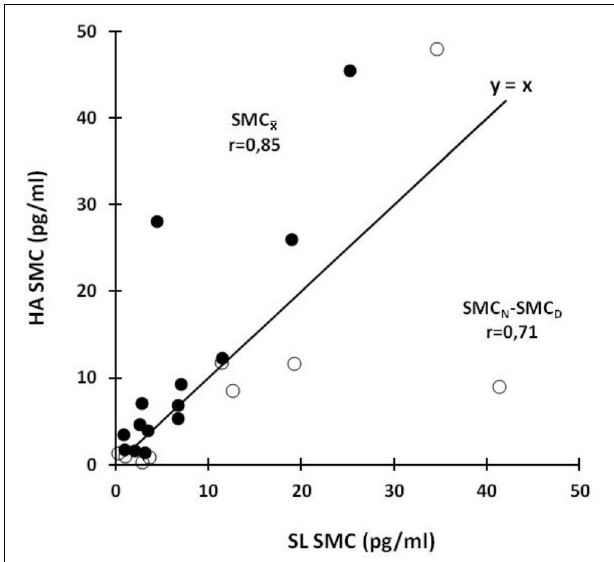
FIGURE 4 | SMC N –SMC D and SMC ¯ x values at SL and at HA. Identity line is depicted as a continuous black line. Black circles show the relation between SL and HA SMC ¯ x values. White circles show the relation between SL and HA SMC N –SMC D